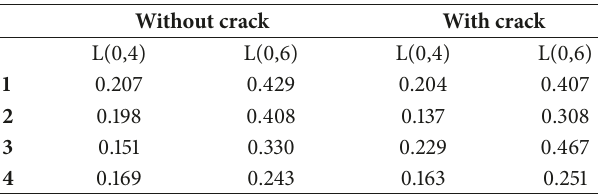
Table 2: Relative amplitudes of L(0,4) and L(0,6) without and with crack when the rotor rotates at